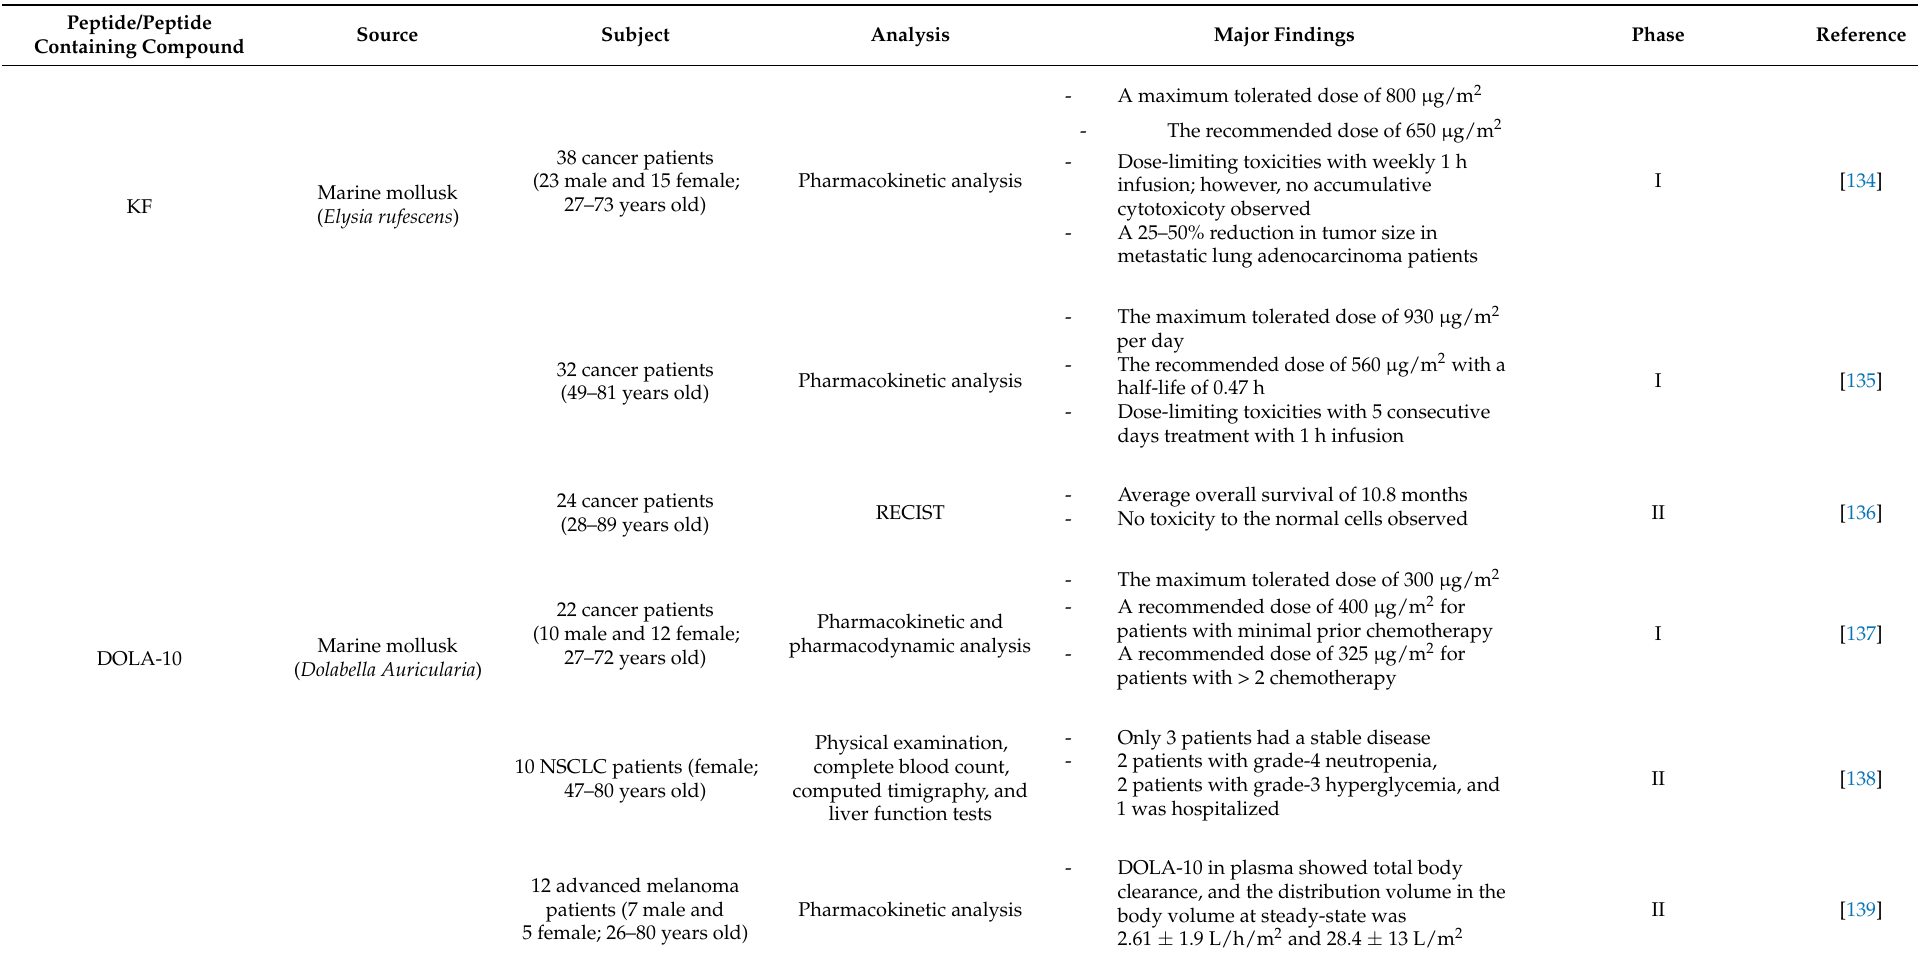
Table 6. Anticancer effects of bioactive peptides from marine animals—clinical